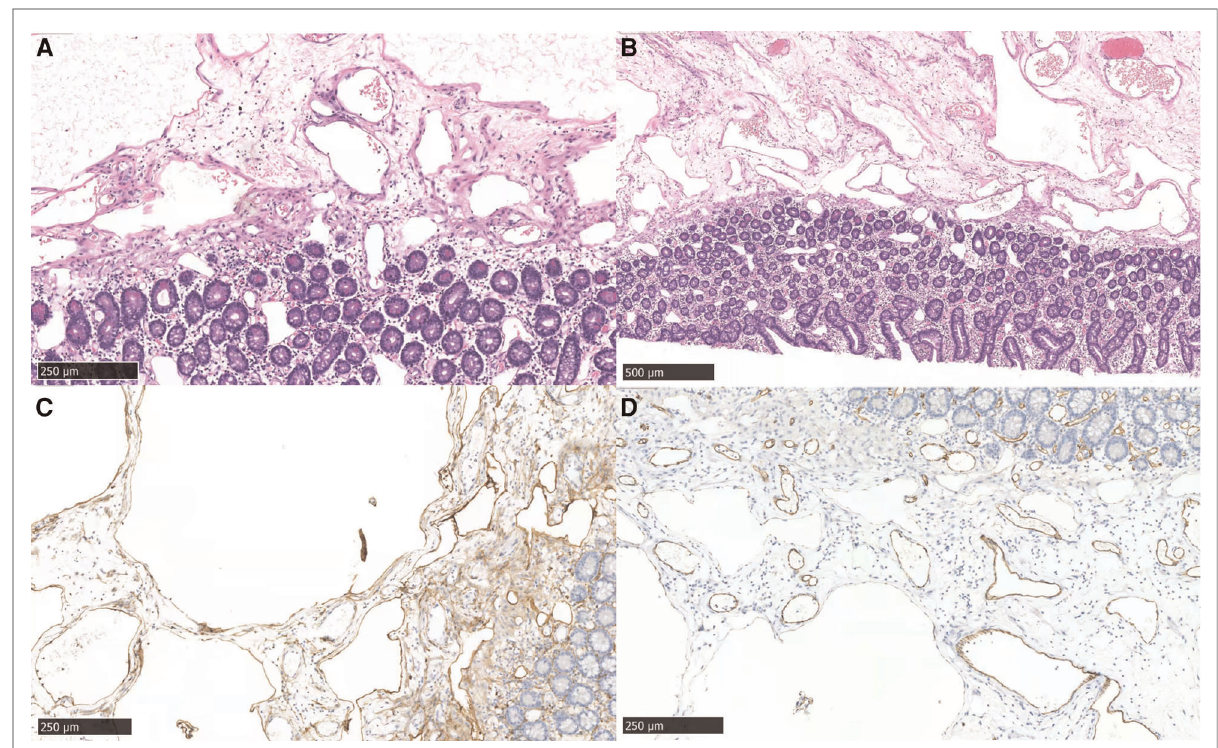
FIGURE 4 Microscopic features of the resected tumor. ( A ) morphology showed cysts in mucosal lamina propria and submucosa (hematoxylin-eosin staining, ×40); ( B ) mucosal lamina propria and submucosa of the jejunum (hematoxylin-eosin staining, ×20); ( C,D ) the endothelial cells were partially positive for D2-40 ( C ) and CD31 ( D )